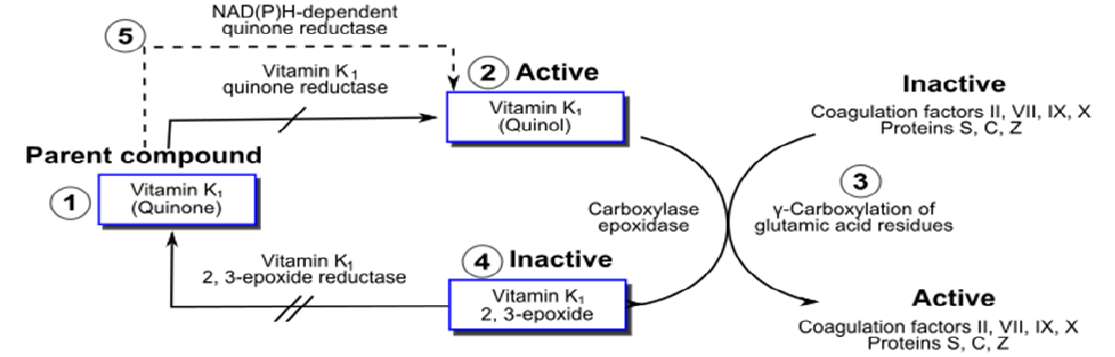
Figure 3. Vitamin K cycle (13)